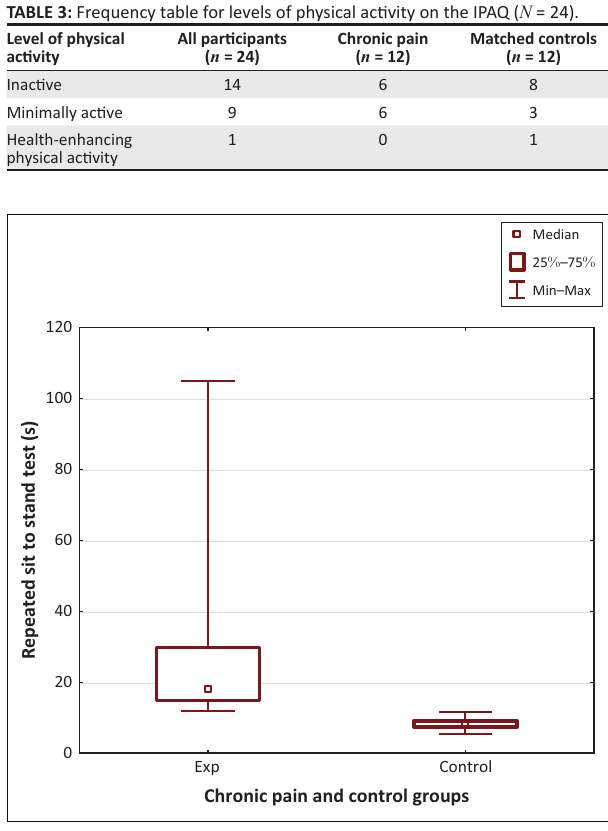
FIGURE 1: Time taken for repeated sit-to-stand test for the chronic pain and control groups.